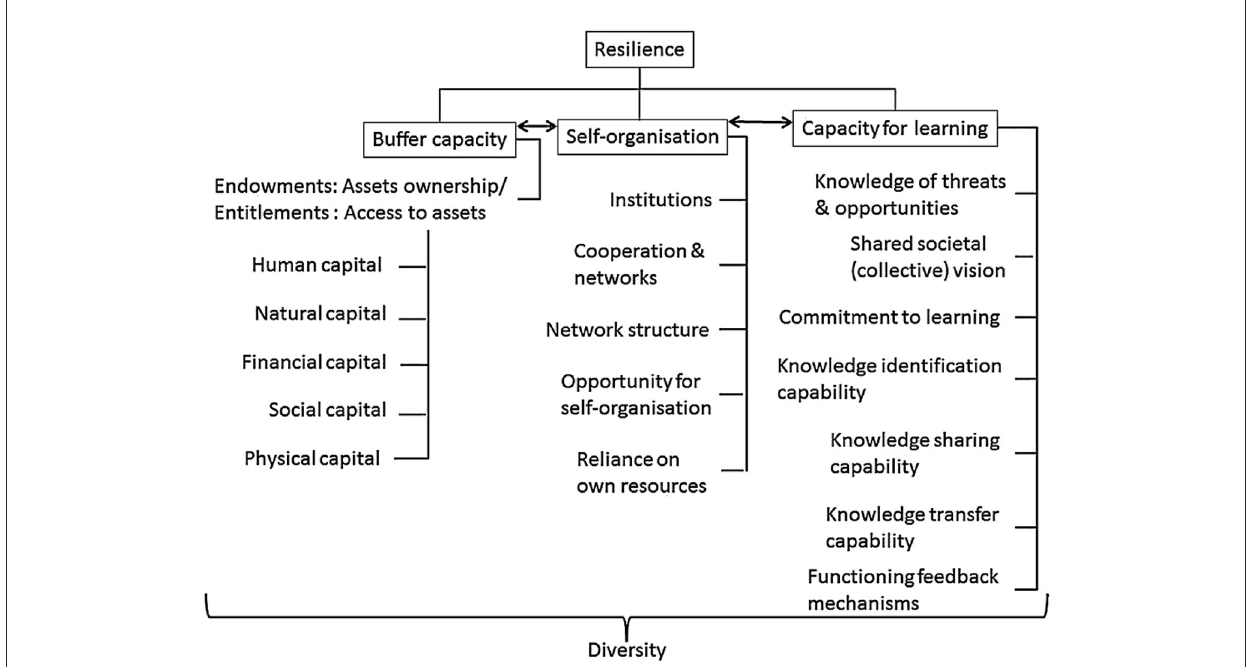
FIGURE1 The applied livelihood resilience framework (Ifejika Speranza et al., 2014, p. 112). The data collection instrument (semi-structured household questionnaire) in 2013 and 2016 were based on the livelihood resilience framework of Ifejika Speranza et al. (2014). The questionnaire was structured according to the three resilience dimensions, namely Buffer Capacity (BC), Self-Organization (SO), and Capacity for Learning